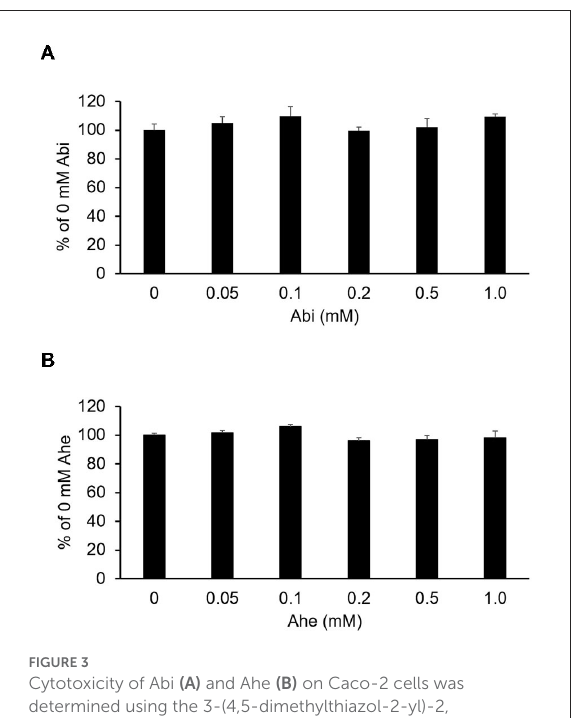
FIGURE3 Cytotoxicity of Abi (A) and Ahe (B) on Caco-2 cells was determined using the 3-(4,5-dimethylthiazol-2-yl)-2, 5-diphenyltetrazolium bromide assay after 6h of incubating Caco-2 cells with Hank’s balanced salt solution containing Abi or Ahe. Each value represents the mean ± SE ( n = 5).